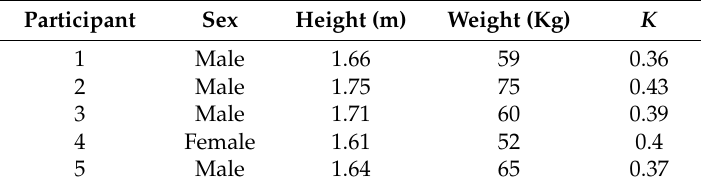
Table 1. Detailed information of all participants ( K is the step length parameter used in Section 4.2.2). Participant